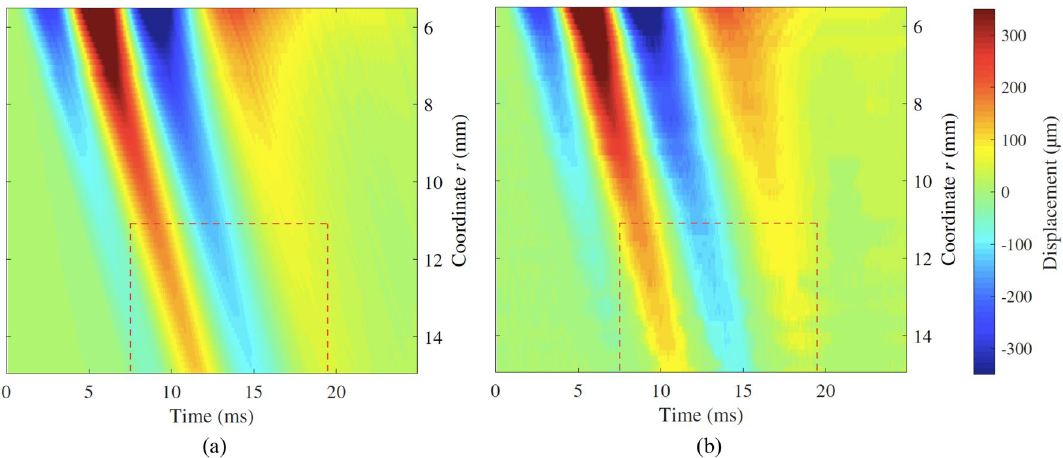
Figure 14. Time-space representation of the wave propagation in the illustrative case for plane B, i.e., with no inclusion. The colour maps represent the particle displacement u θ for ( a ) the model simulation and ( b ) the HSC test.